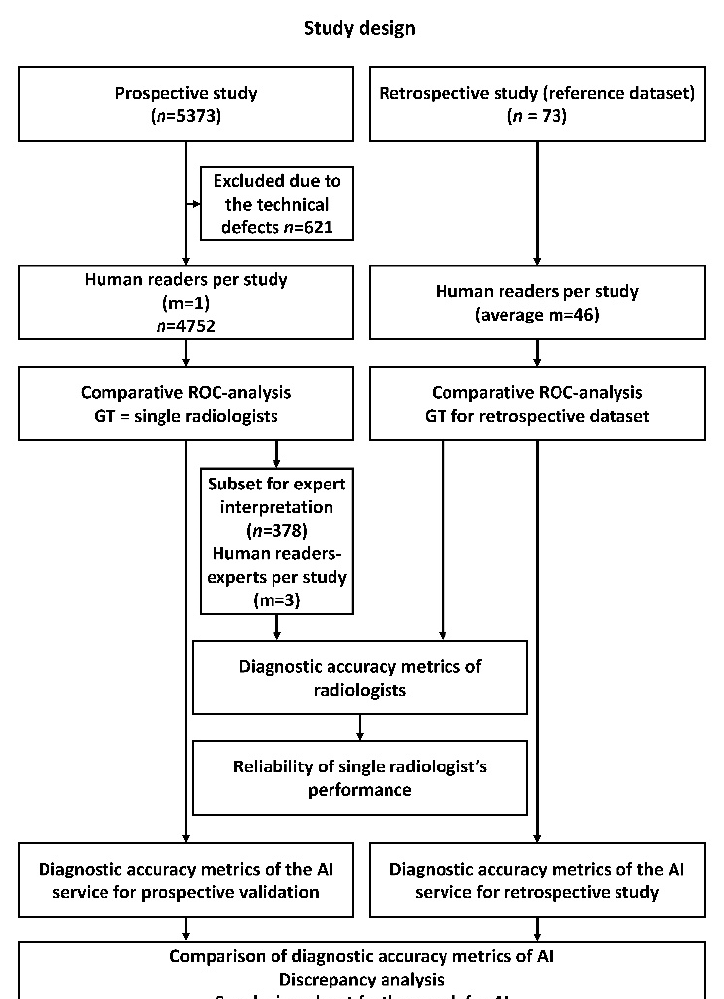
Figure 1. The study design flowchart. GT-ground truth; m—amount of human readers; n —amount of studies.